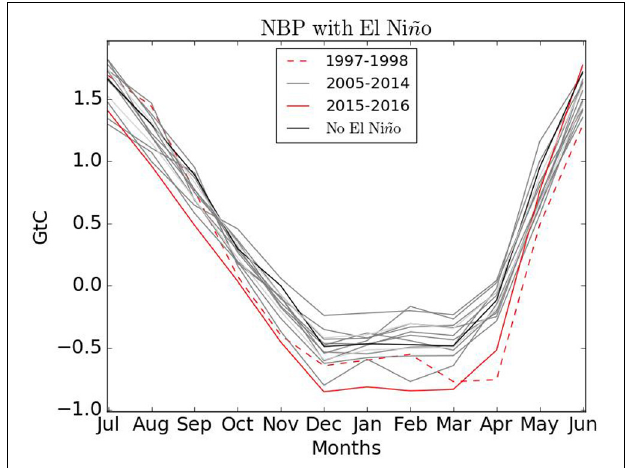
FIGURE 11 | Global terrestrial (GtC/month) NBP for time series of 10 years from July–June. 2005–2014 shown in gray, large El Niño years shown in red (1997/98 dashed; 2015/16 solid), “No El Niño” shown in